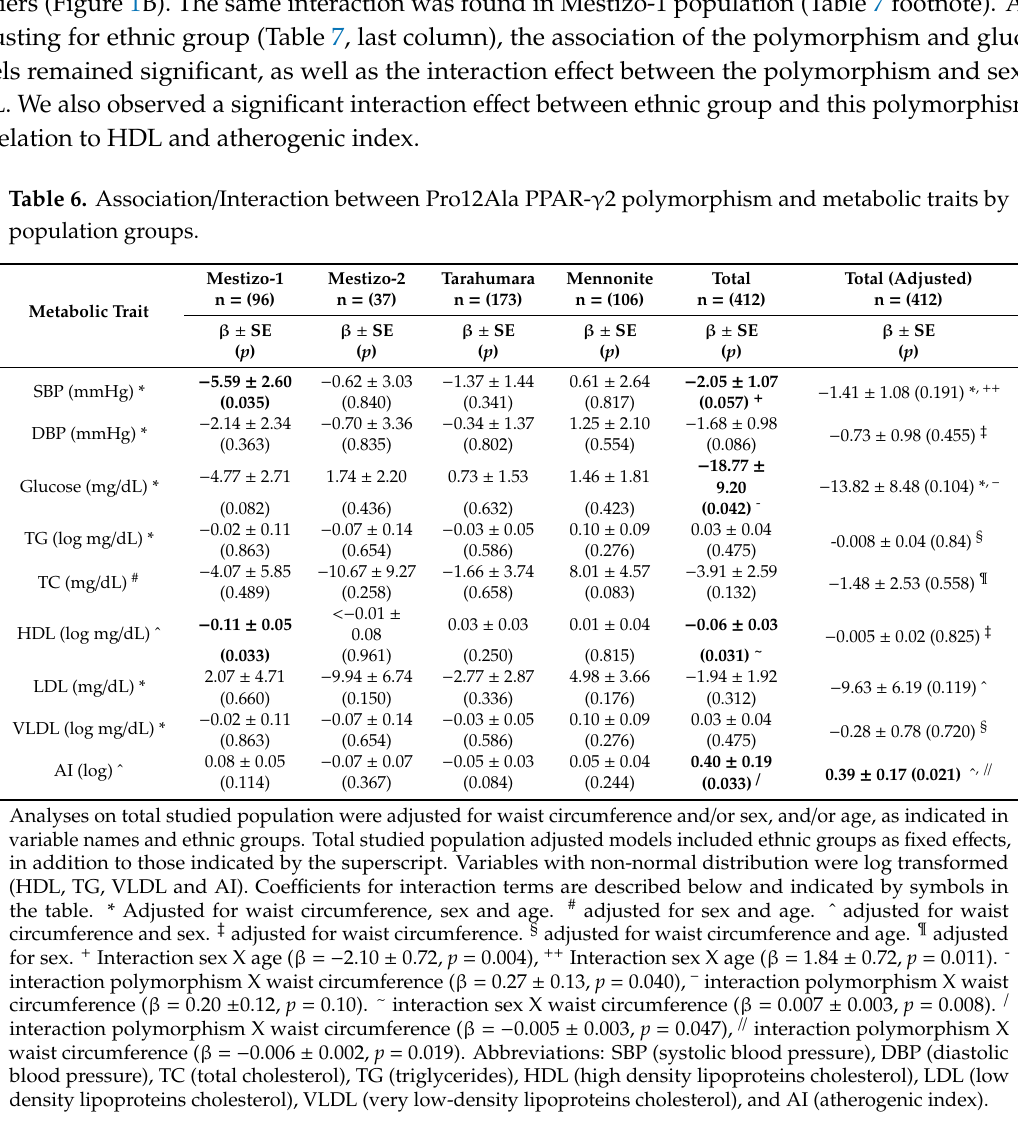
the table. * Adjusted for waist circumference, sex and age. # adjusted for sex and age. ˆ adjusted for waist circumference and sex. ‡ adjusted for waist circumference. § adjusted for waist circumference and age. ¶ adjusted